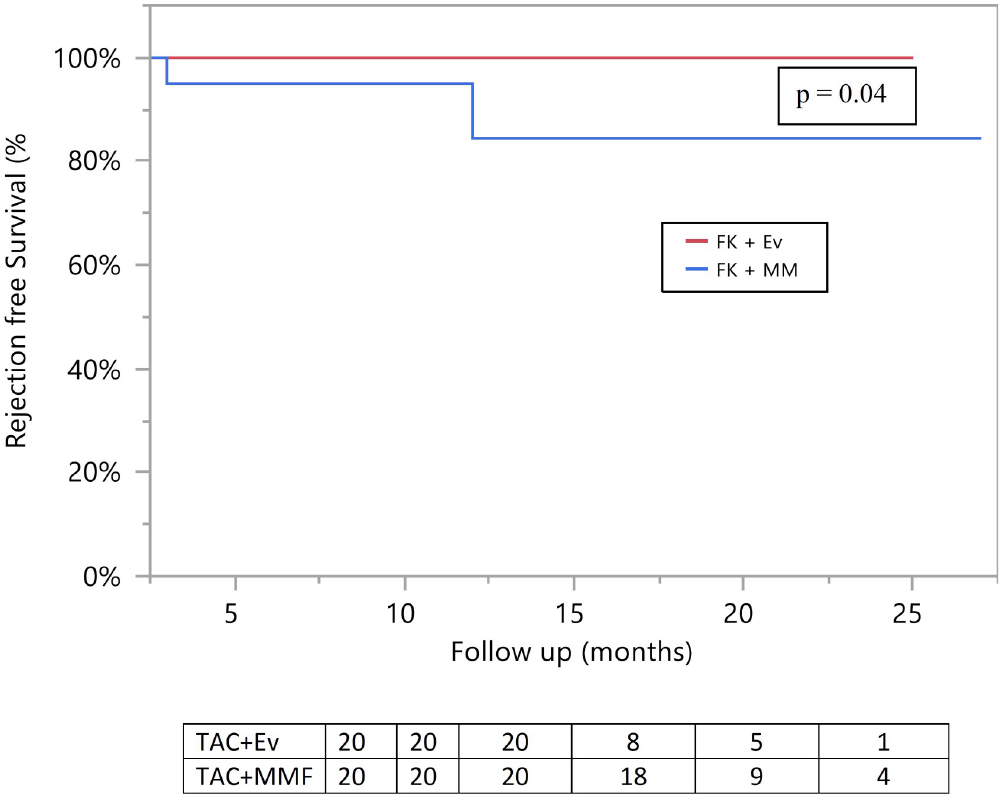
Fig 2. Comparison of biopsy proven rejection-rates between study